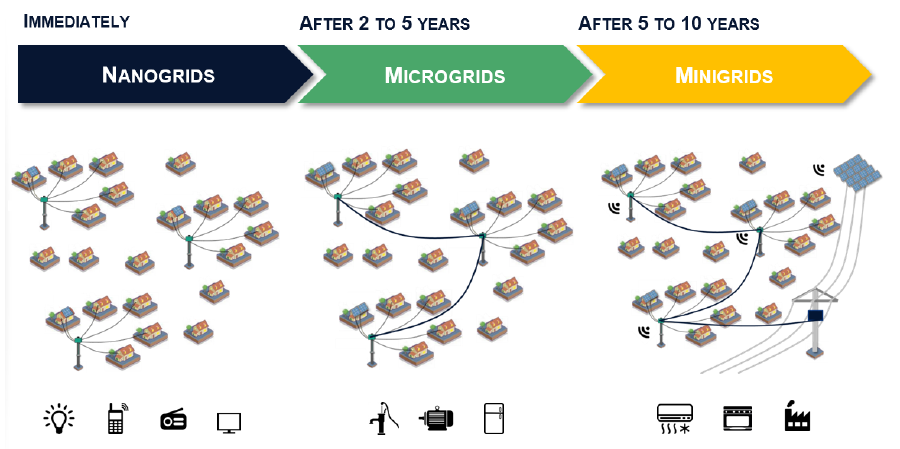
Figure 2. Progressive building of power